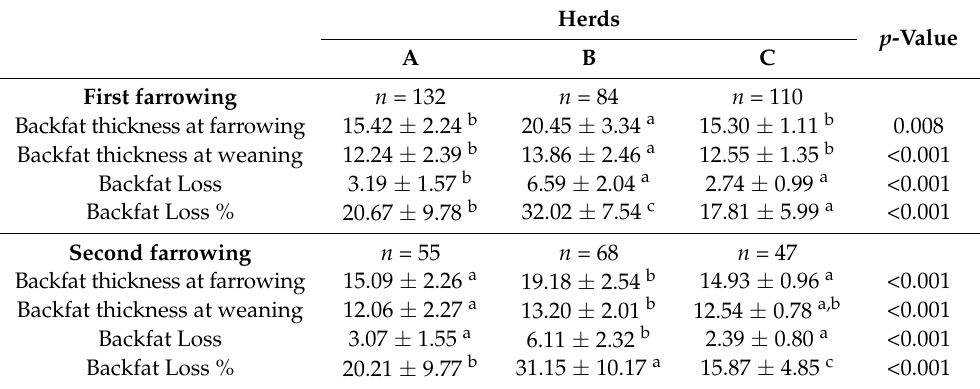
Table 7. Results of backfat thickness (mm), backfat loss (mm) and backfat loss % (mean ± SD) of replacement gilts of different genetic lines in three farrow-to-finish herds in Greece, at farrowing and weaning, and at first and second farrowing.